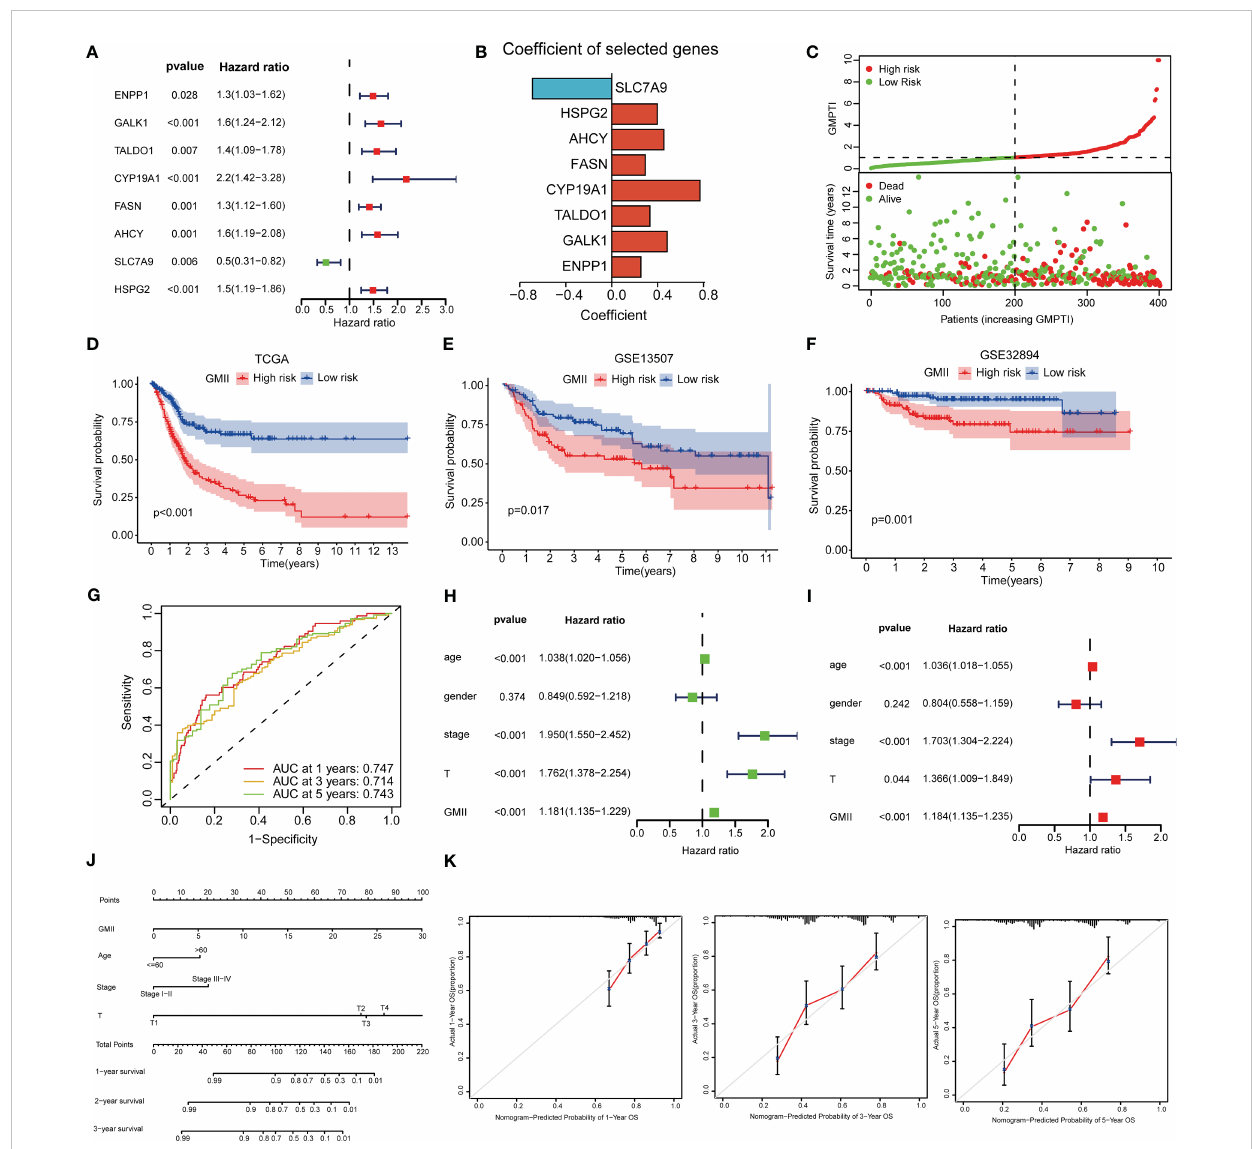
FIGURE 3 Construction of prognostic treatment index related to glutamine metabolism and validation of external data sets. (A) Forest maps of eight GRGs obtained by multivariate Cox analysis. (B) Construct eight GRGs coef fi cients of GMII. (C) Survival state of TCGA queue. (D) Kaplan-Meier survival curve of the TCGA cohort. (E) Kaplan-Meier survival curve of the GSE13507 cohort. (F) Kaplan-Meier survival curve of the GSE32894 cohort. (G) ROC curve of TCGA queue. (H, I) univariate and multivariate regression analysis. (J) Histogram based on GMII, age, clinical stage, and T-stage. (K) Calibration curves show the consistency of 1-year, 3-year, and 5-year survival rates predicted from bias-adjusted prognostic columns with actual survival